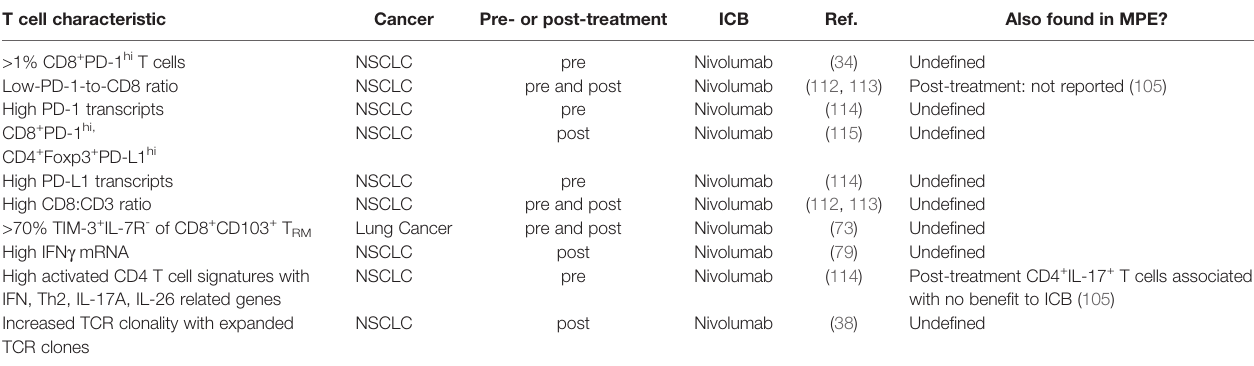
TABLE 1 | Intratumoral T cell characteristics that associate with clinical bene fi t to ICB in lung cancer patients. T cell